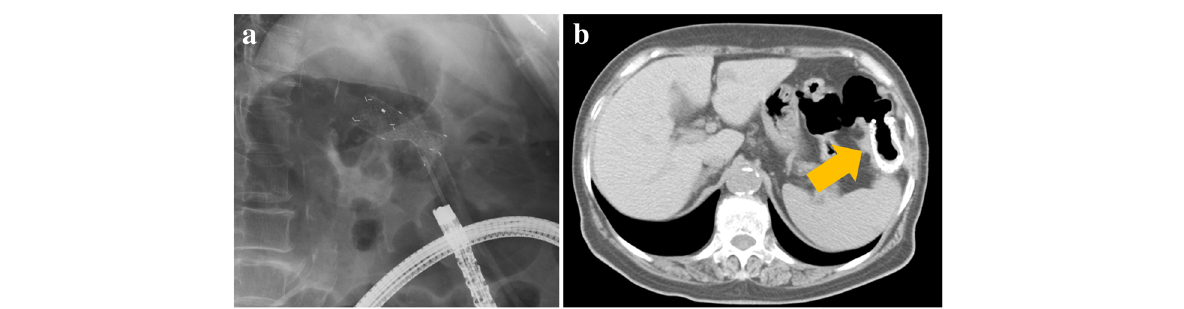
Fig. 2 Fluoroscopy and computed tomography findings after colonic stent placement. a Colonic stent was placed in the descending colon under fluoroscopic guidance. b Colonic stent (yellow arrow) reduced the obstruction